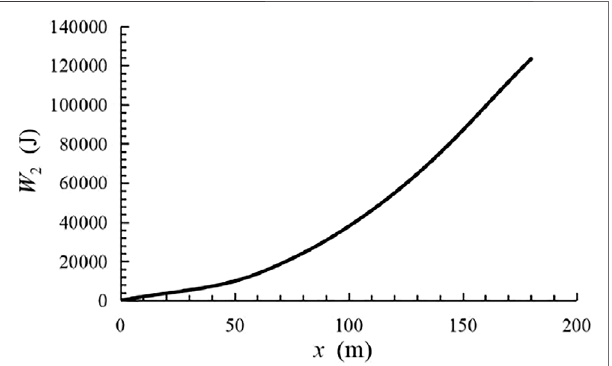
FIGURE 6 | Cumulative energy consumption of tube